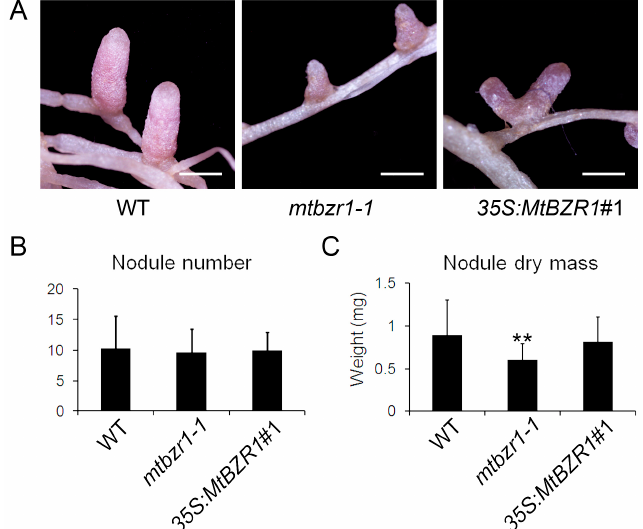
Figure 4. Nodule development in wild type (WT), mtbzr1-1 , and 35S:MtBZR1 #1 transgenic line. ( A ) Photos of nodules from one-month-old WT, mtbzr1-1 , and 35S:MtBZR1 #1 transgenic line. Scale bar = 1 mm. Nodule number ( B ) and dry mass ( C ) in WT, mtbzr1-1 , and 35S:MtBZR1 #1 transgenic line 21 days after rhizobial inoculation. Values are the means ± SD ( n = 25); T = 2; ** p < 0.01.